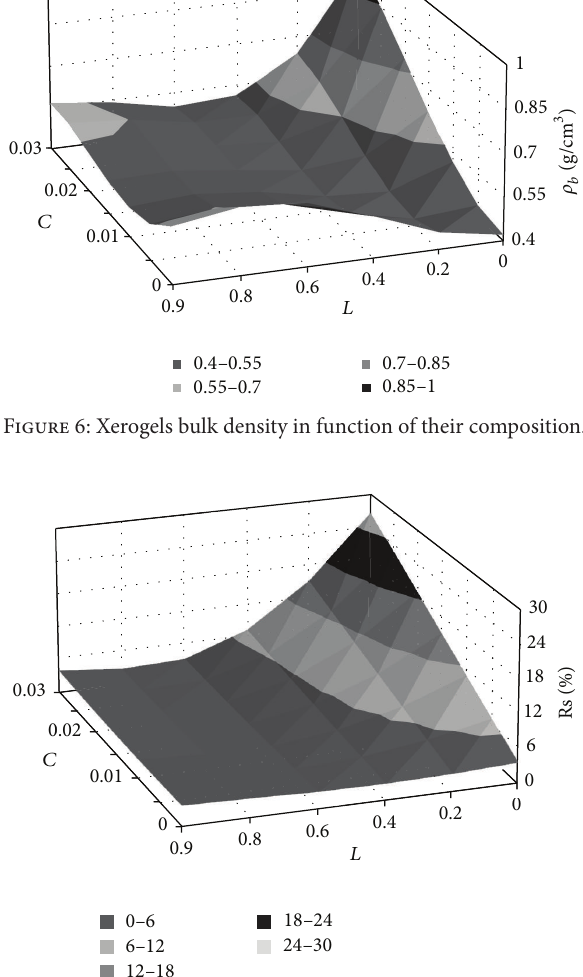
Figure 7: Xerogels shrinkage in function of their